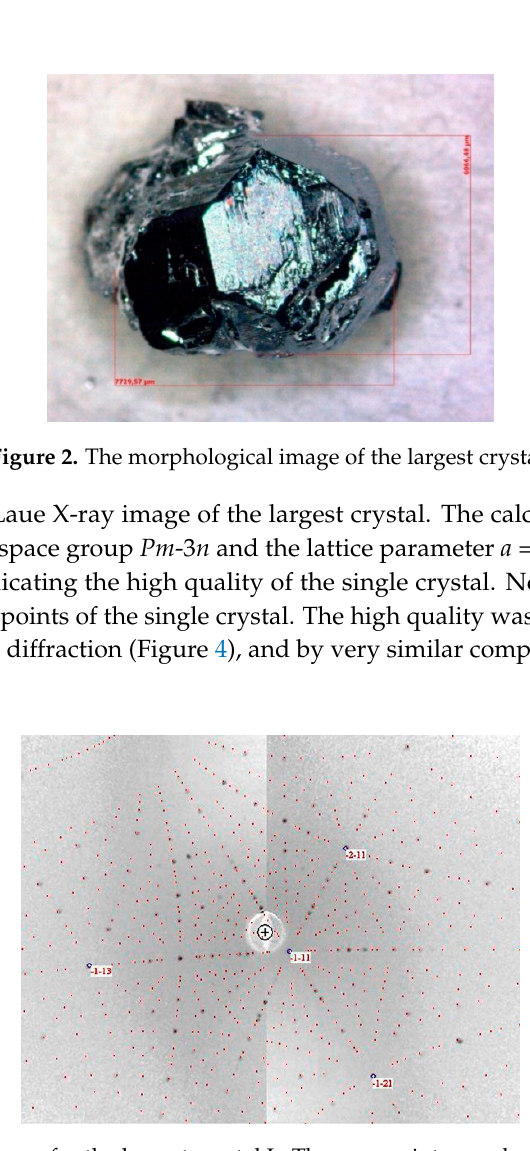
Figure 3. Laue X-ray image for the largest crystal L. The grey points are observed, the red points are simulated for the cubic system (SG: Pm -3 n ; a = 1.05324(1) nm). Measurements have been performed from different surfaces.